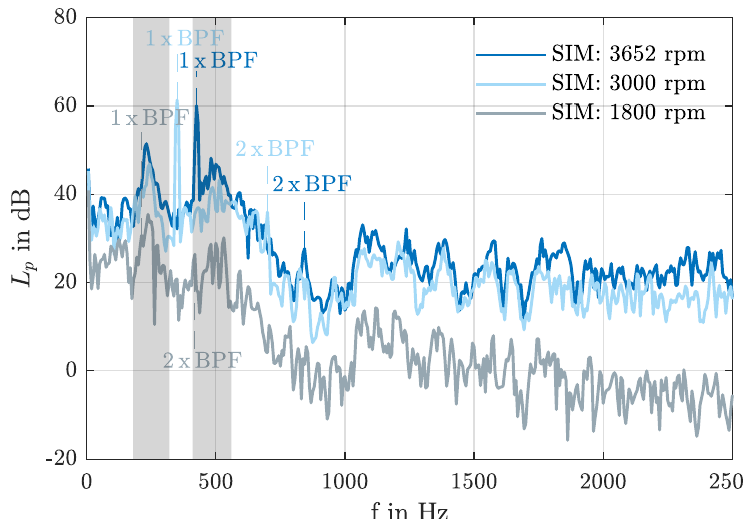
Figure 10. Acoustic narrow band spectra of variation of rotational speed for Q / Q opt = 1.0 at microphone position M10 determined by